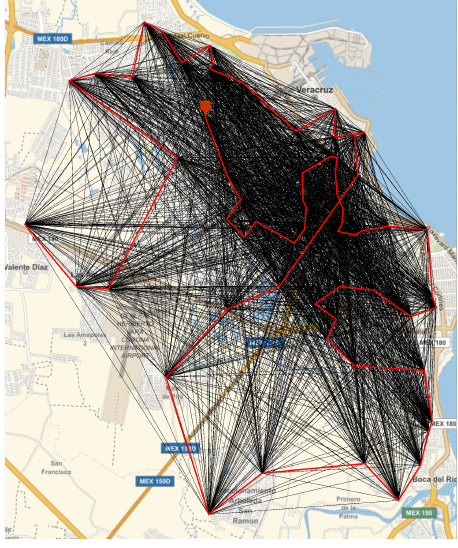
Figure 21. Exploration of a strategic location for a merchandise distribution center in the Veracruz- Boca del Rio